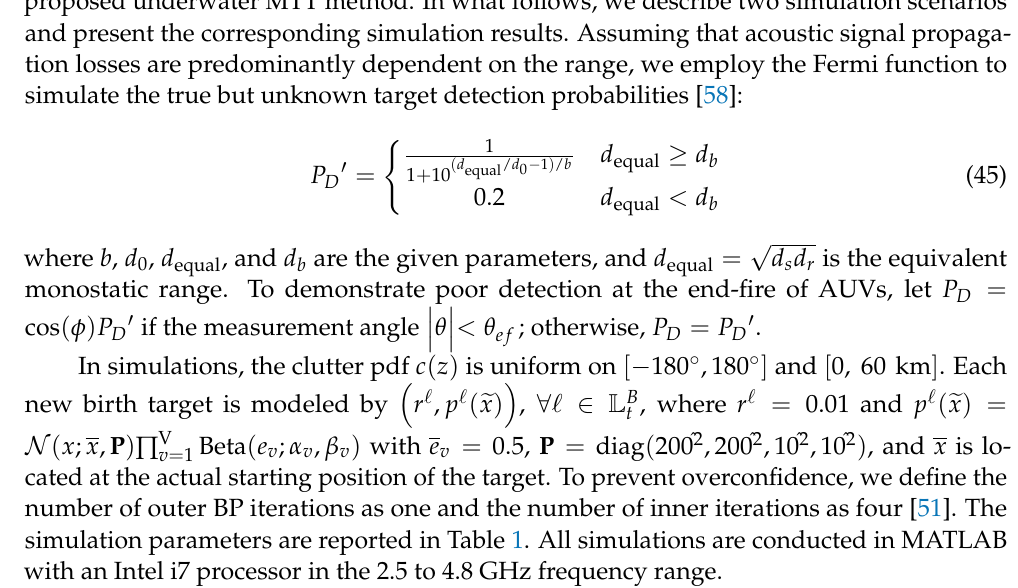
Table 1. Simulation parameters.